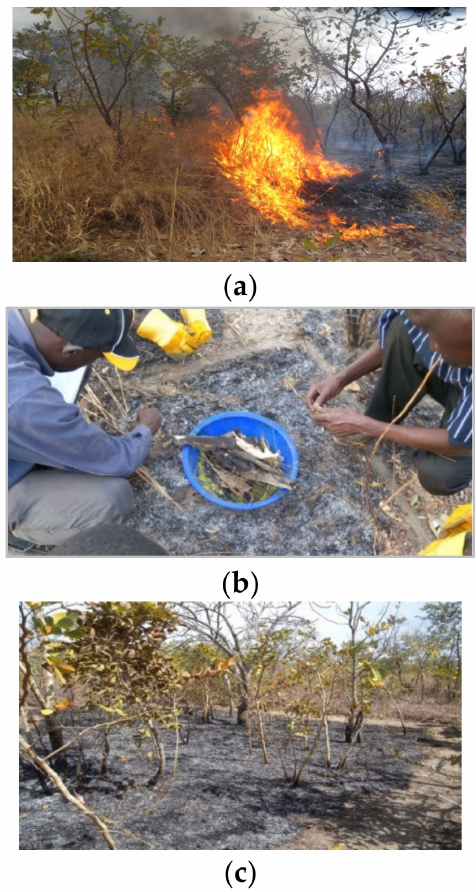
Figure 4. Scales of fire emission analysis. ( a ) The scale of combustion efficiency (CE) of emissions. Inefficient combustion results in a smoky fire with higher levels of CO and lower levels of CO 2 , leading to a lower MCE. ( b ) Scale of combustion completeness (CC) (ash and residuals). Incomplete combustion results in lower CC. ( c ) Scale of plot, uniformity of burn completeness, or BAC. The plot shown has very high BAC (nearly 100% for fine fuels). It also has low scorch height (<1 m) typical of a low-intensity, slow-burning